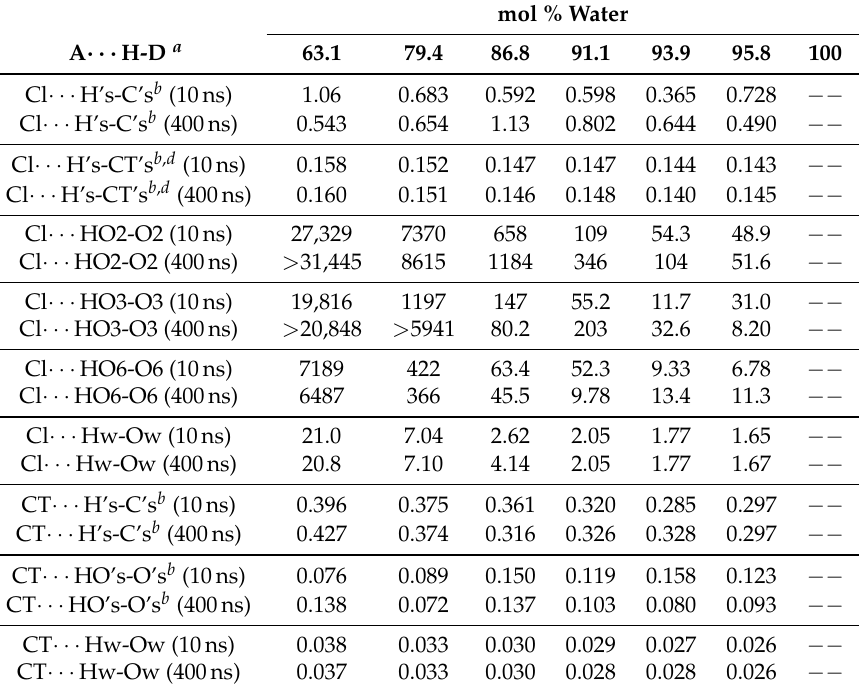
Table 3. TBPCl hydrogen bonding lifetimes (ps), Part 1 of